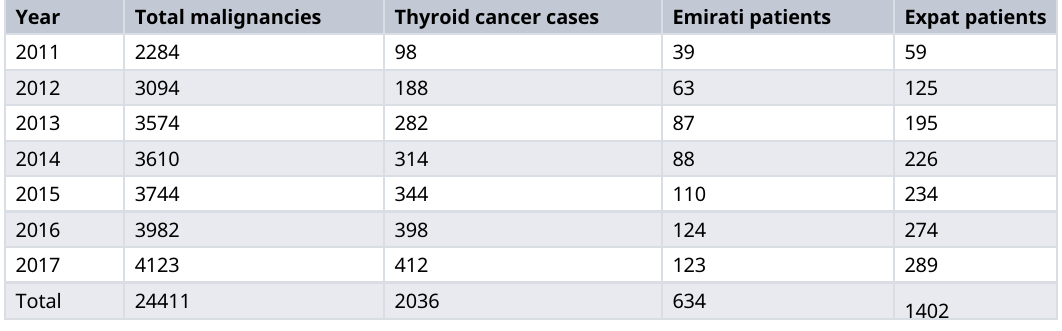
Table 4. UAE thyroid cancer percentage compared to total malignancies from 2011 to 2017.